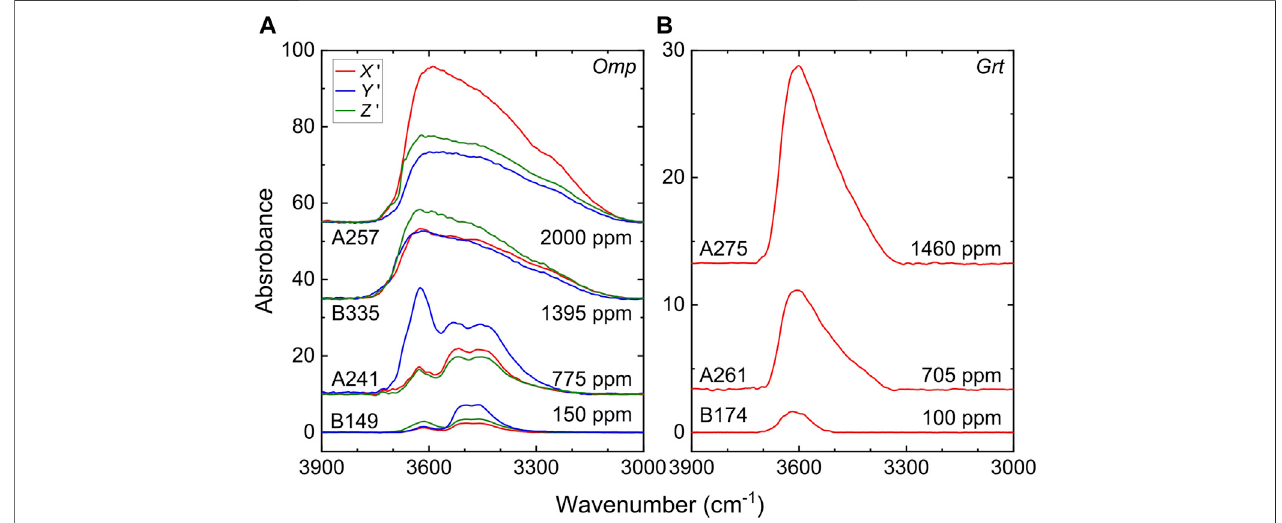
FIGURE1| RepresentativeFT-IRspectraofpre-annealedomphaciteandgarnet. (A) Polarizedspectraofomphacite alongwiththreeorthogonaldirections( X ′ , Y ′ , and Z ′ ) and (B) unpolarized spectra of garnet (see text). Spectra of 150 ppm H 2 O omphacite and 100 ppm H 2 O garnet (bottom in each panel) are from Liu et al. (2019). Spectra were normalized to 1 cm thickness and vertically offset. Omp , omphacite; Grt , garnet.